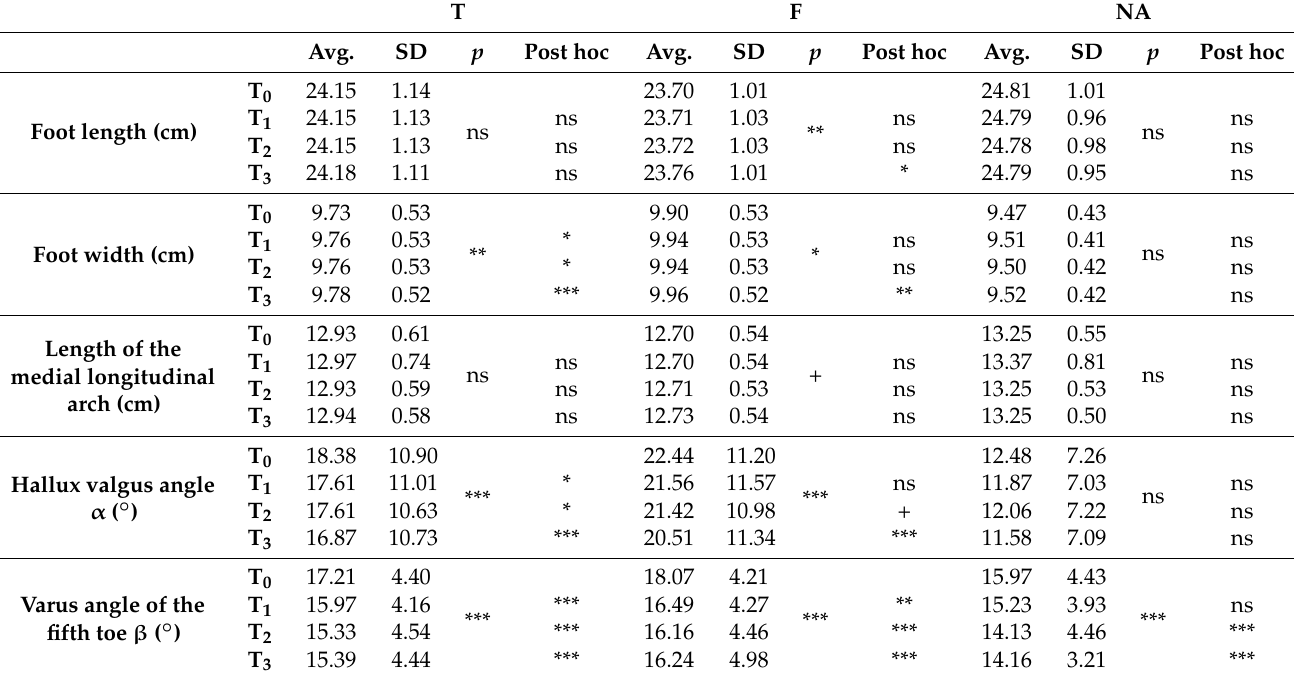
Table 3. Foot geometry before treatments (T 0 ) and after 1 (T 1 ), 2 (T 2 ), and 3 (T 3 ) procedures